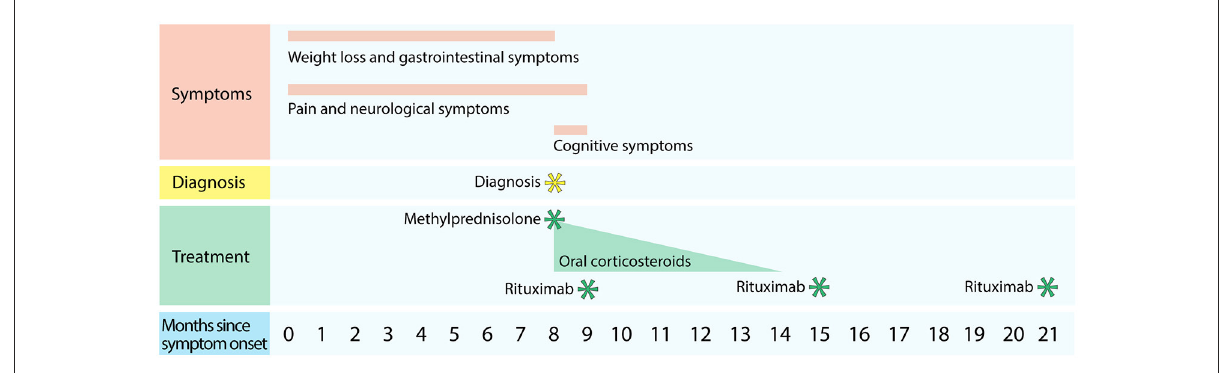
FIGURE1 Time course of symptoms, diagnosis, and treatment.